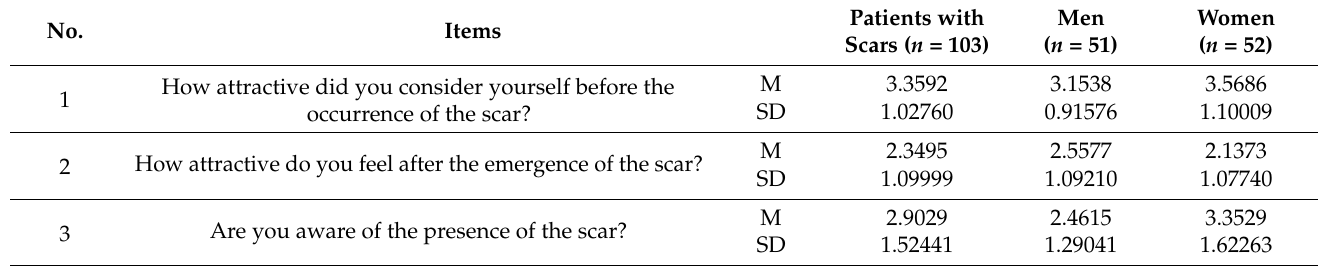
Table 2. Items, mean and standard deviations of the